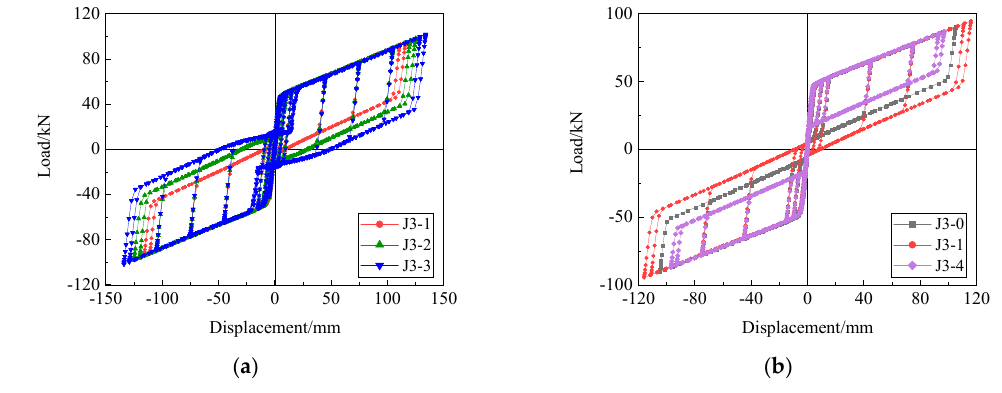
Figure 26. Load–displacement curves: ( a ) J3-1~J3-3; ( b ) J3-0, J3-1, J3-4.